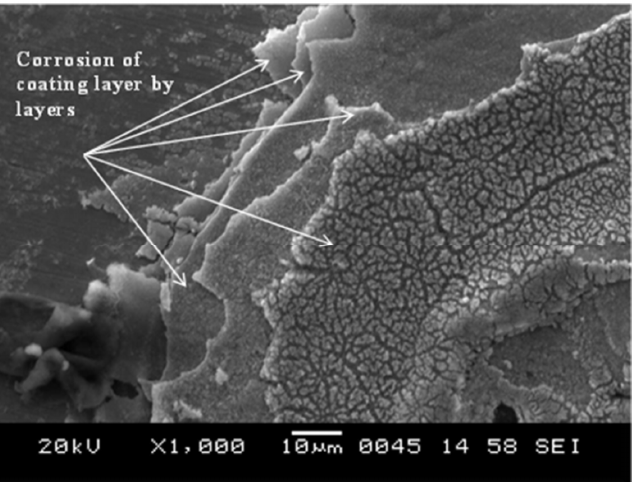
Figure 9. SEM image of multilayer electroplating after the corrosion analysis: (Zn-Fe) 3/5/4/square. Because the coatings have multiple layers with varying degrees of failure, the corro- sion agent’s path is obstructed. This is why multilayer coating takes longer than single- layer coating for the corrosive chemical to pass through coating fl aws and into the sub- strate material. So, the path of the corrosive chemical is either lengthened or blocked. In the multilayer coatings formed during corrosion, the Zn-Fe alloy fi lm with a lower wt. % of Fe underneath a top layer with a higher wt. % of Fe dissolves through pores and mi- crocracks. The blockade e ff ect of the Zn-Fe fi lm, which has a high wt. % of Fe, and the sacri fi cial e ff ect of the Zn-Fe fi lm, which has a lower wt. % of Fe, can both be used to explain the protection e ff ectiveness of multilayer coatings [36]. 4. Conclusions The multilayer Zn-Fe coatings were formed using single bath technique (SBT) with di ff erent current pulses namely square and triangular, and their corrosion behaviors were examined. With all types of current pulses, the corrosion resistance of multilayer coatings increased with an increase in the layers up to 300 and then decreased. The signi fi cant pro- gress in the resistance towards corrosion of Zn-Fe multilayer coatings are a tt ributed to sharp changes in the composition of alternate layers due to sharp changes in current den- sities observed in square current pulses, and gradual changes in the composition of dif- ferent layers due to gradual changes in current densities observed in triangular current pulses during deposition. In ideal conditions, the multilayer coatings formed using square and triangular current pulses were found to be fi ve and four times more corrosion-re- sistant than single-layer coatings of the same thickness. The formation of multilayer coat- ings was con fi rmed by SEM images. The enhanced protection of the multilayer is due to the blockage of pores by the successive layers. Author Contributions: R.S.B.: Conceptualization, methodology, formal analysis, investigation, writing—original draft preparation, funding acquisition, M.K.B.: resources, data curation, software,